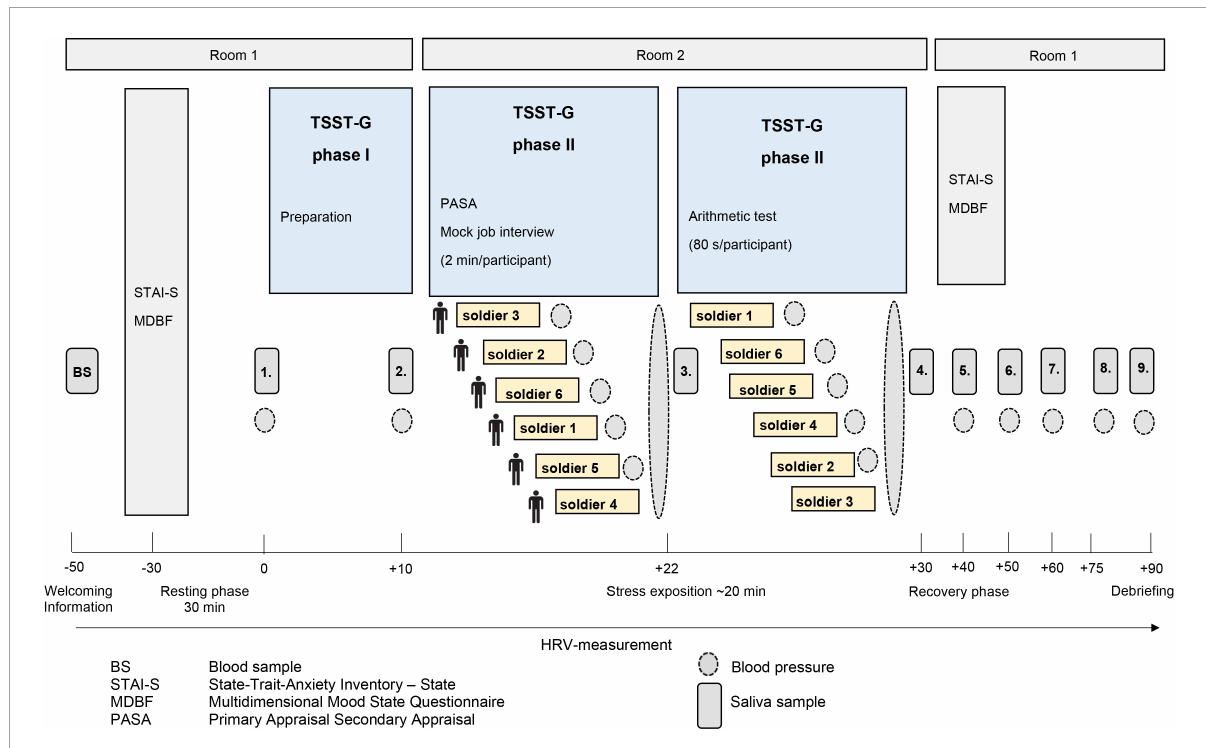
FIGURE1 Illustration of the standardized process description of the trier social stress test for groups (TSST-G). The trial design was adapted according to von Dawans, Kirschbaum and Heinrichs